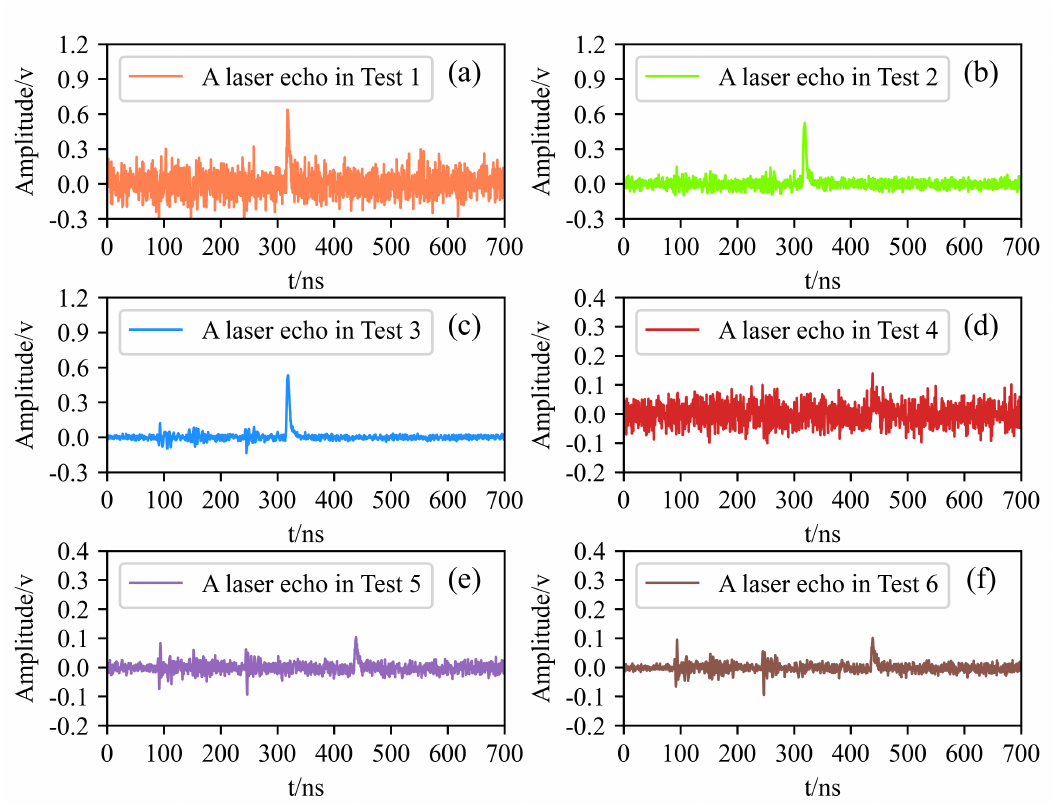
Figure 5. The laser echoes of the tests: ( a ) a laser echo in test.1;( b ) a laser echo in test.2; ( c ) a laser echo in test.3; ( d ) a laser echo in test.4; ( e ) a laser echo in test.5; ( f ) a laser echo in test.6.